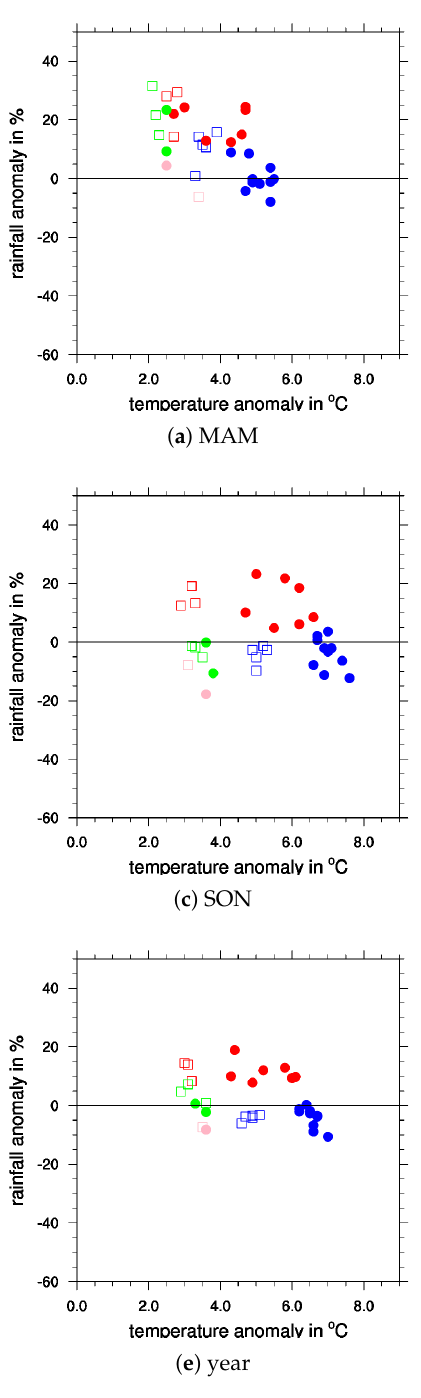
Figure 6. Comparison of EPISODES downscaling results based on RCP8.5 (CMIP5) and SSP5-8.5 (CMIP6) for Germany. The symbols (open: CMIP5; filled: CMIP6) show the Germany-wide mean climate change signal in annual/seasonal precipitation and temperature for 2071–2100 with respect to 1971–2000. Different colours correspond to different GCMs. (Seasons: ( a ) spring (MAM), ( b ) summer (JJA), ( c ) autumn (SON), ( d ) winter (DFJ), and ( e )